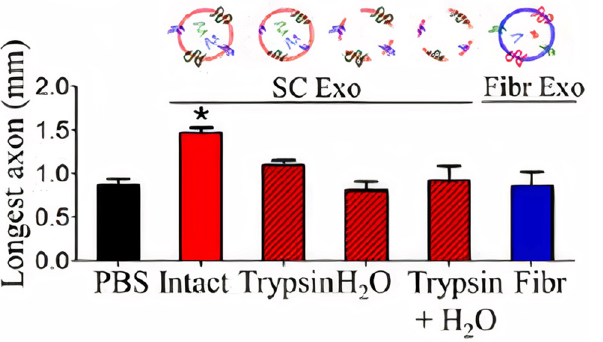
Figure 10. Effect of pre-treated exosomes from SCs and intact exosomes from fibroblasts (Fibr) on axonal regeneration three days after axonal damage [20]. Figure and caption reproduced with permission from John Wiley and Sons.